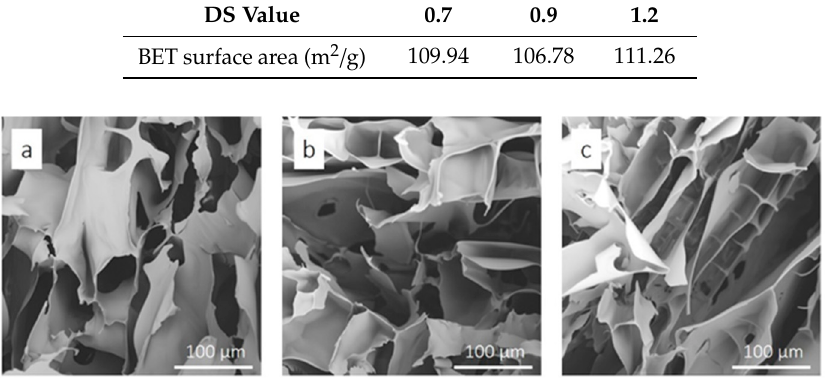
Figure 2. The SEM images of CMC aerogels with different DS value: ( a ) 0.7, ( b ) 0.9 and ( c ) 1.2.